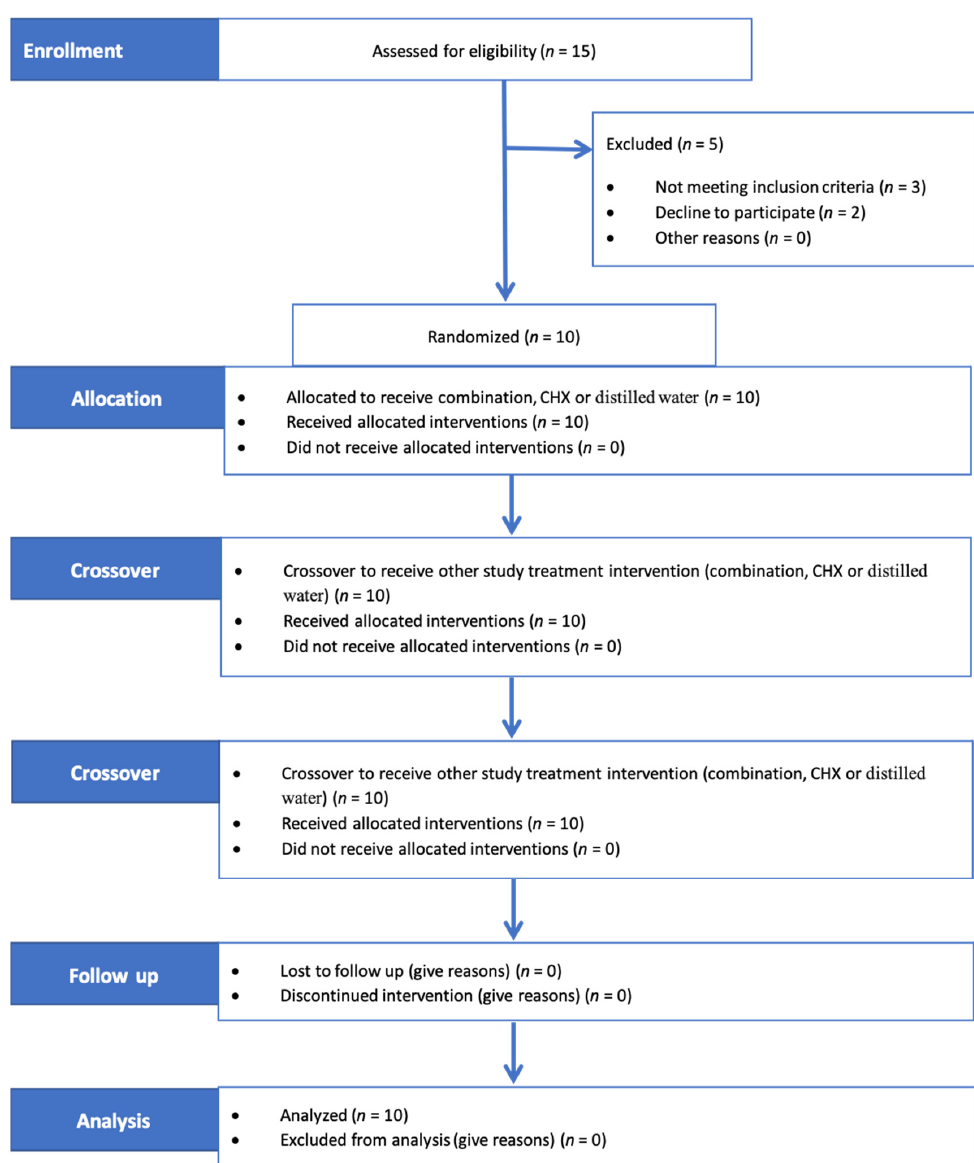
Figure 1. Consort 2010 flow of the study. Subjects rinsed with three mouthwashes through three clinical trial periods intermitted by two washout periods. Combination composed of 7.82 mg/mL miswak ( Salvadora persica L.) root ‐ stick and 0.25 mg/mL green tea; CHX = 0.12% chlorhexidine. The IL ‐ 1 β concentration was measured using a commercially available ELISA assay (MYBioSource, Southern California, San Diego, CA, USA), which is based on an antibody sandwich technique. After the designated samples were defrosted at room temperature, wells precoated with a monoclonal antibody specific for human IL ‐ 1 β were incubated